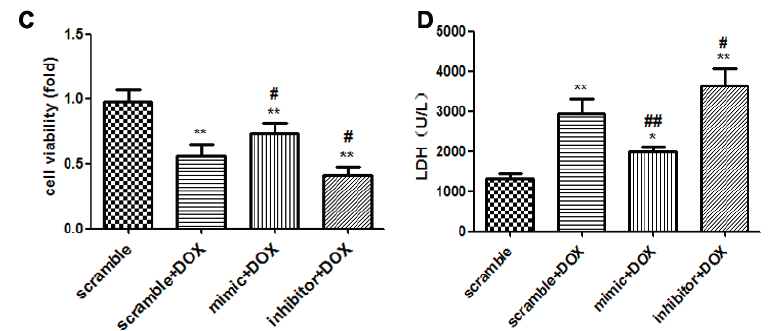
Figure 3. Overexpression and knockdown of miR-21 influenced the DOX-induced cytotoxicity in H9C2 cells. ( A ) The levels of miR-21 in H9C2 cells transfected with rno-miR-21 mimics/inhibitors/scrambled controls were measured by qRT-PCR. * , p < 0.05, compared to that of cells treated with scramble, n = 3; ** , p < 0.01, compared to that of cells transfected with scramble, n = 3; ( B ) Apoptosis induced by DOX (1 µM for 24 h) in H9C2 cells transfected with miR-21 mimics/inhibitors. * , p < 0.05, compared to that of cells transfected with scramble, n = 3; ** , p < 0.01, compared to that of cells transfected with scramble, n = 3; # , p < 0.05, compared to that of cells transfected with scramble + DOX, n = 3; ( C ) Cell viability; and ( D ) Activity of lactate dehydrogenase. * , p < 0.05, compared to that of cells transfected with scramble, n = 6; ** , p < 0.01, compared to that of cells transfected with scramble, n = 6; # , p < 0.05, compared to that of cells transfected with scramble + DOX, n = 6; ## , compared to that of cells transfected with scramble + DOX, p < 0.01, n =